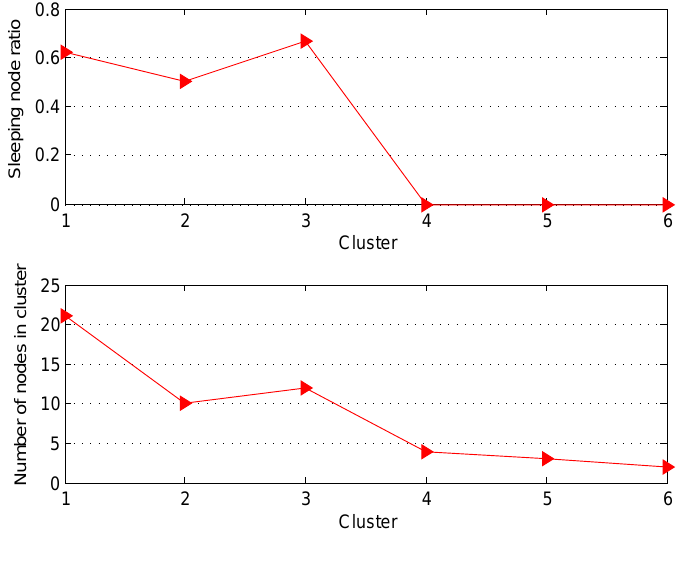
Figure 2. SNR vs . Nodes